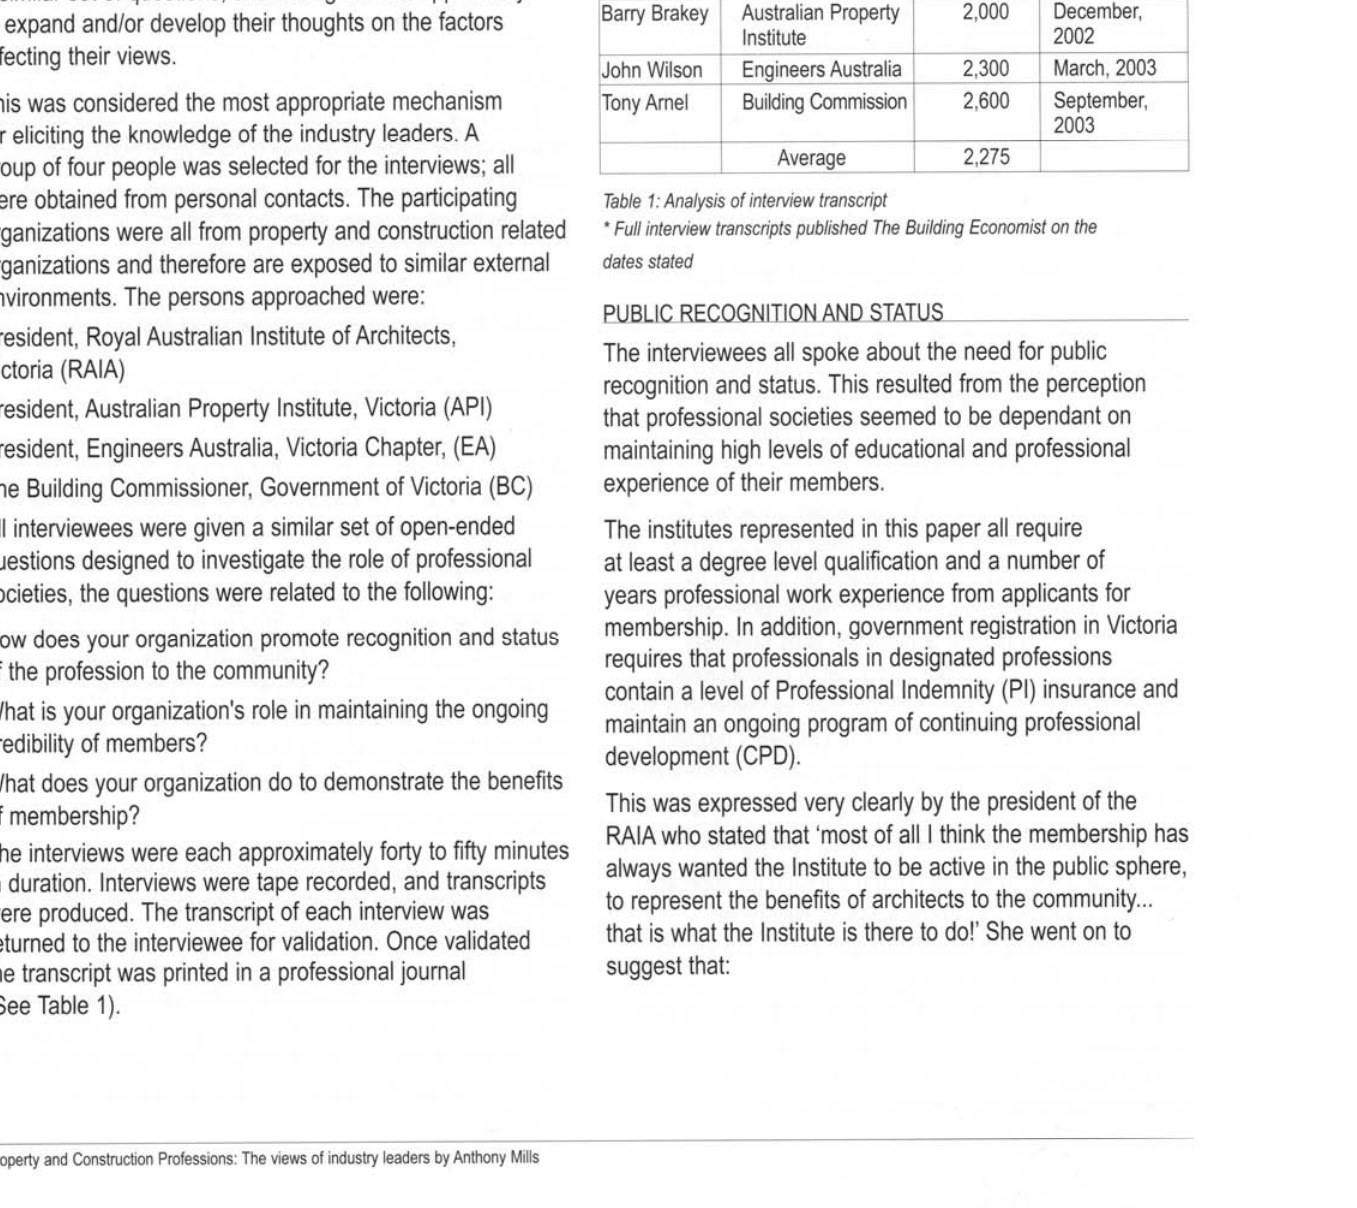
Table 1: Analysis of interview transcript * Full interview transcripts published The Building Economist on the dates